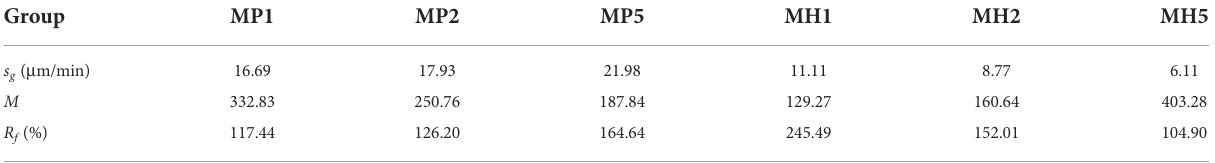
TABLE 2 Changes in parameters during fl occulation of microalgae with modi fi ed clay under coagulation conditions.